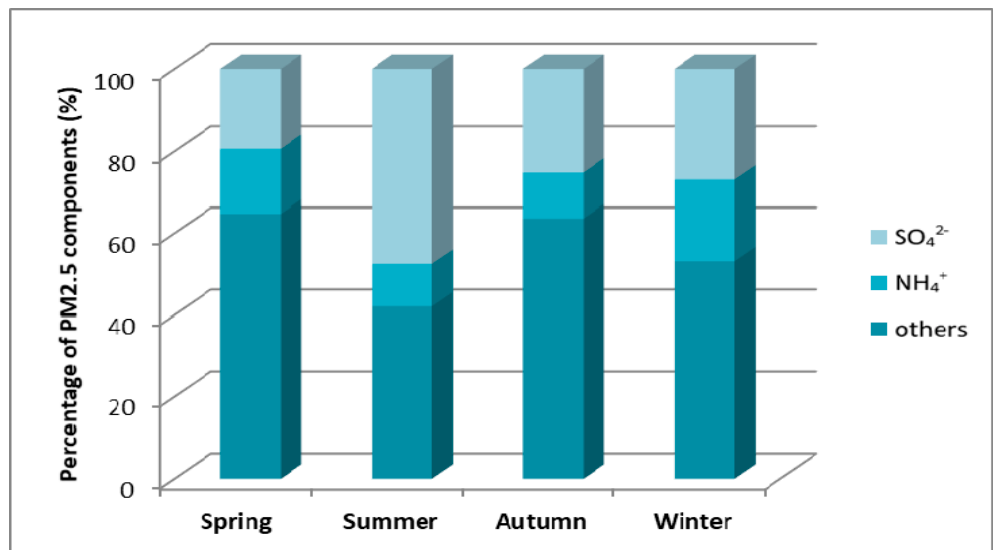
Figure 13. Mass percentage of PM2.5 components in particular seasons of 2010 in the monitoring station in Diabla Góra [23].